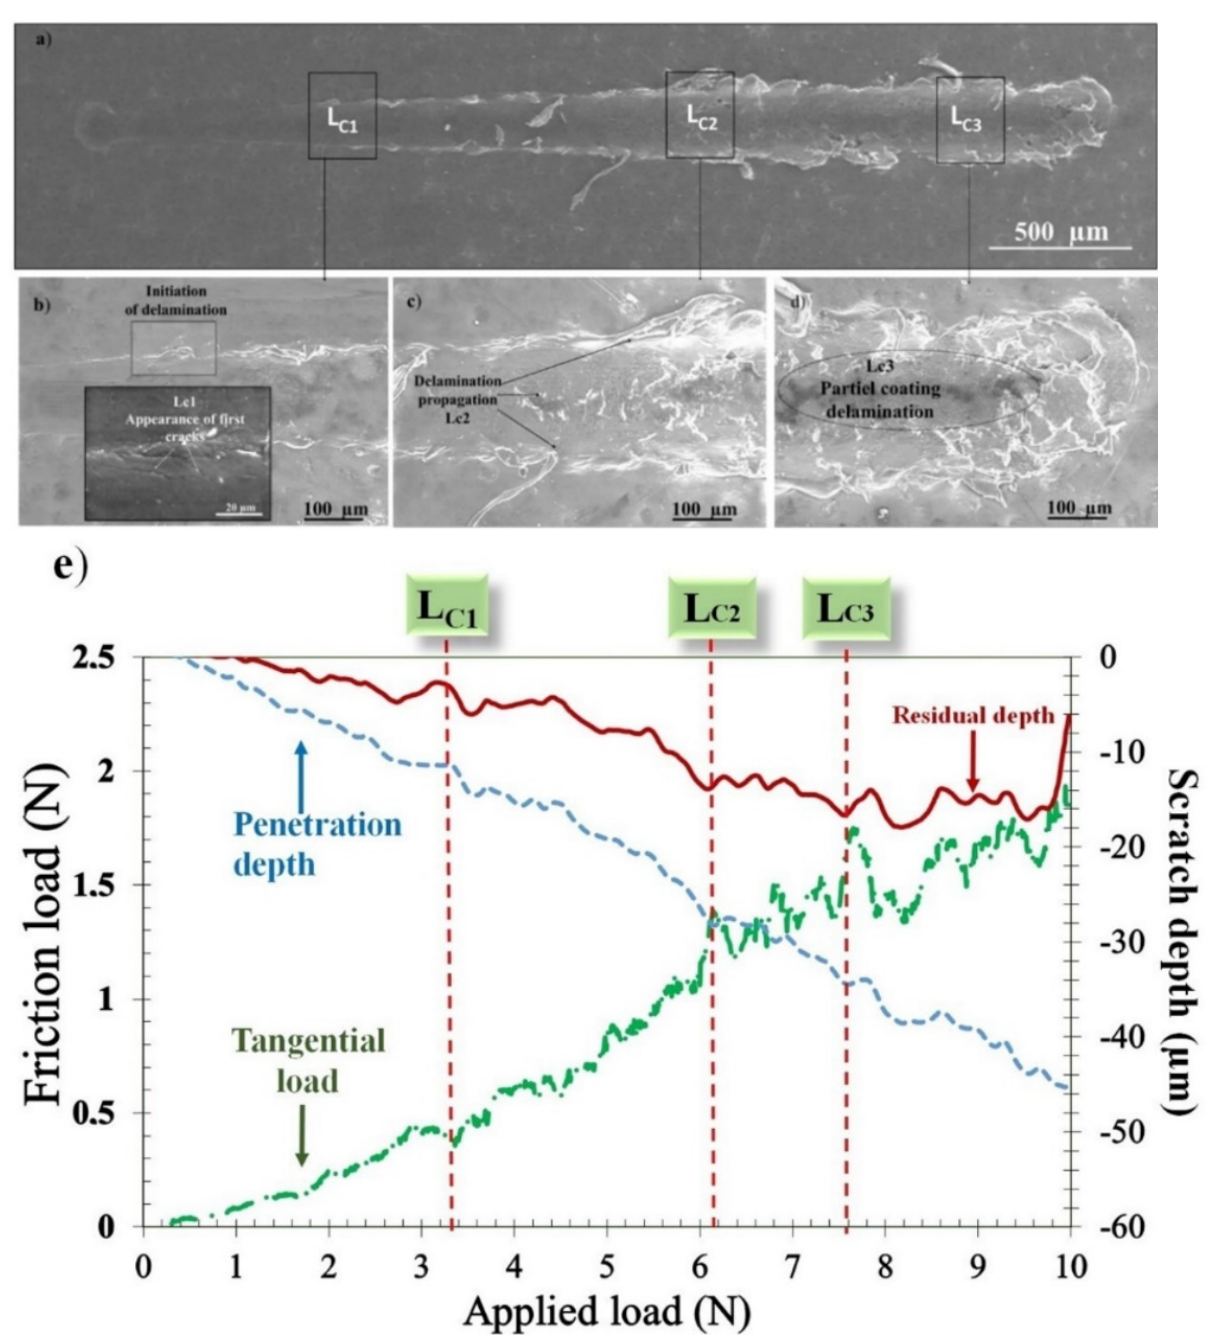
Figure 4. Progressive scratch test on an FEP coating. ( a ) SEM micrographs of scratch tracks. Magnified photo at ( b ) L c1 , ( c ) L c2 , and ( d ) L c3 . ( e ) Tangential load, penetration, and residual depths as functions of the applied